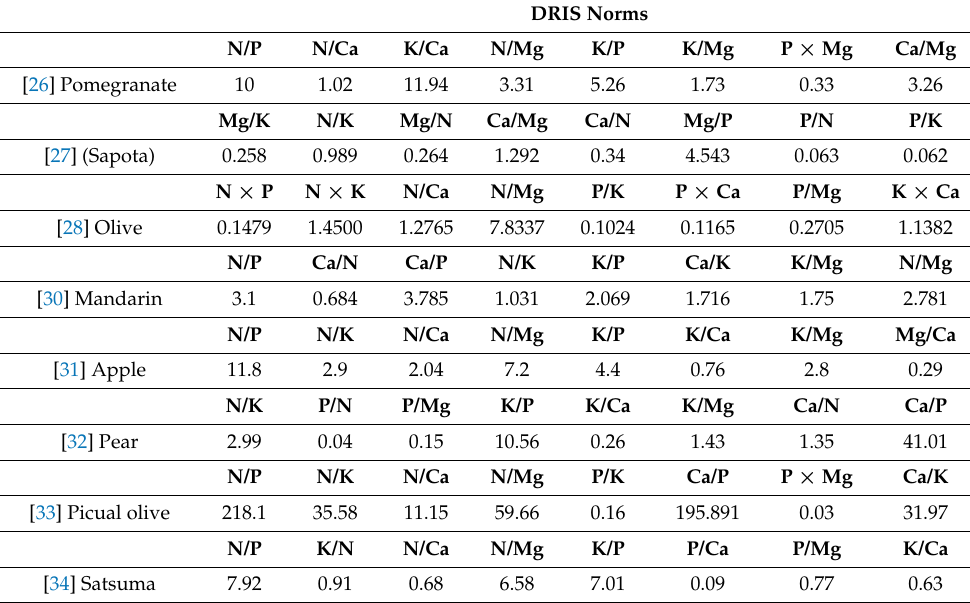
Table 5. DRIS norms for other fruits trees according to other publications.